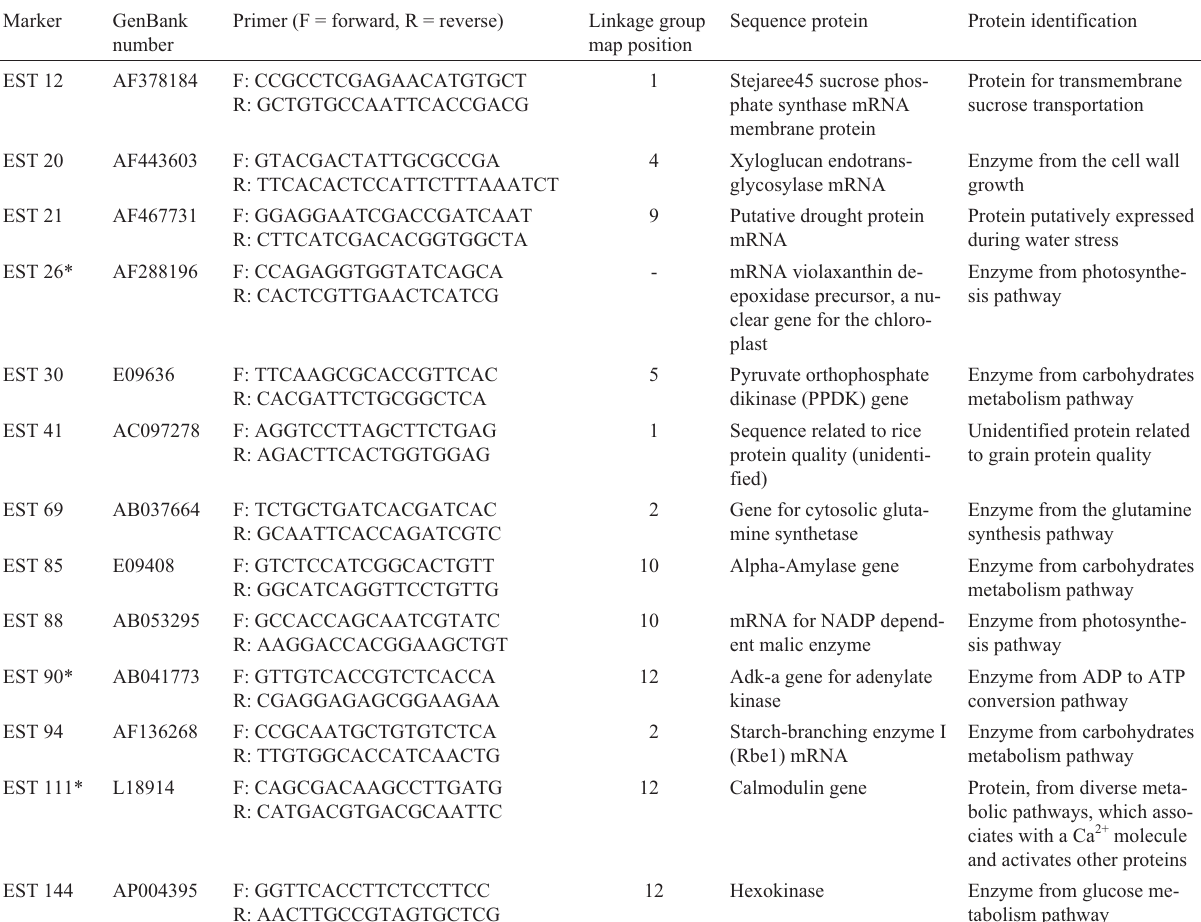
Table 2 - Expressed sequence tag (EST) markers showing polymorphism between the Oryza glumaepatula and Oryza sativa parents. The annealing tem- perature was 56 °C for EST 30 and EST 69 but 48 °C for all the other markers. An asterisk indicates EST-derived single nucleotide (SNP) markers.